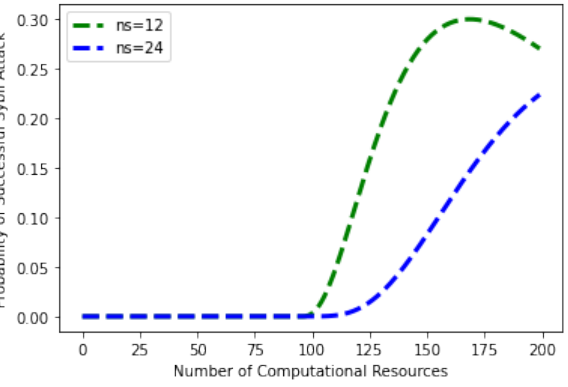
Figure 13. Probability of Sybil attack versus number of Sybil identities.